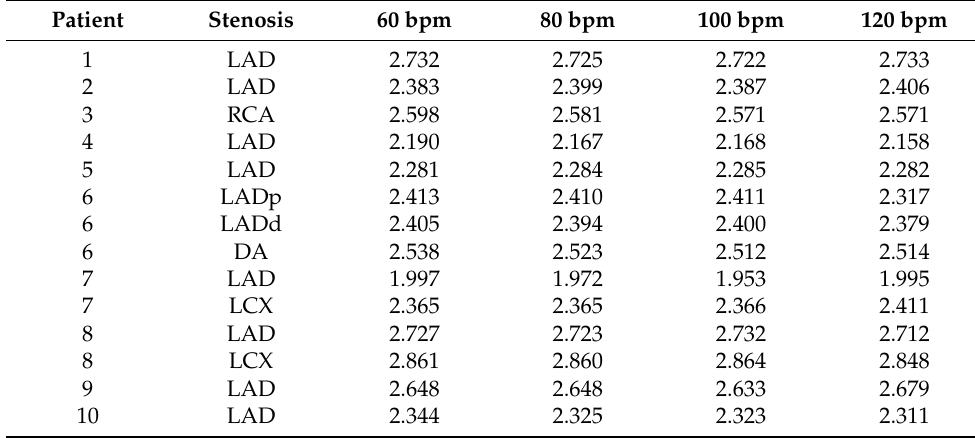
Table A3. CFR values for various heart